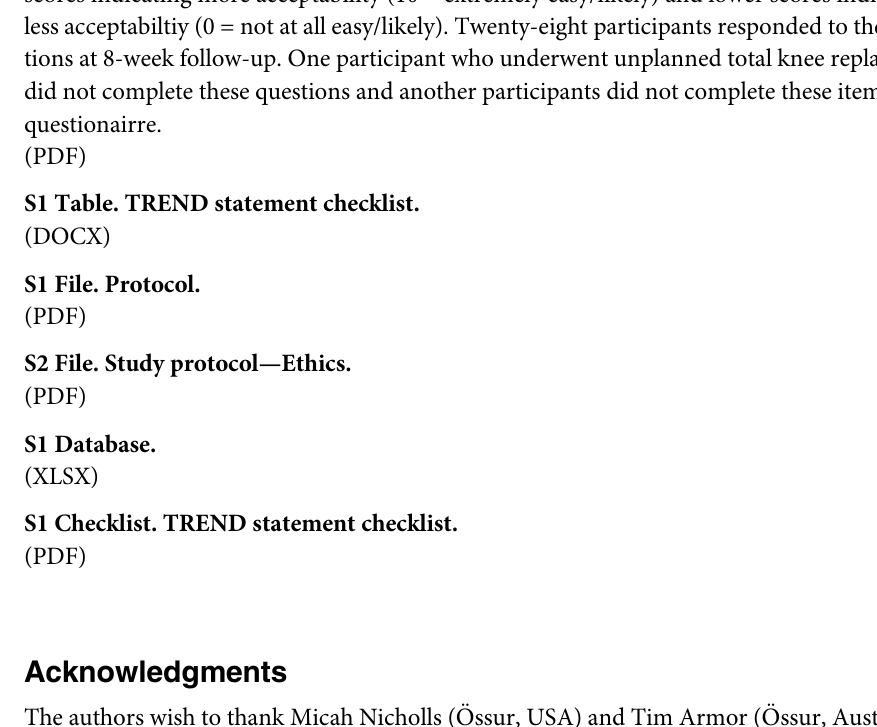
S5 Fig. Hours brace worn. Weekly report of the number of hours the valgus knee brace was worn per week. The number of participants providing weekly data are described, some partici- pants did not provide hours each week for various reasons. (PDF) S6 Fig. Numeric rating scale (NRS) scores for acceptabiltiy realated questions. Higher NRS scores indicating more acceptability (10 = extremely easy/likely) and lower scores indicating less acceptabiltiy (0 = not at all easy/likely). Twenty-eight participants responded to these ques- tions at 8-week follow-up. One participant who underwent unplanned total knee replacement did not complete these questions and another participants did not complete these items on the questionairre. S1 Table. TREND statement